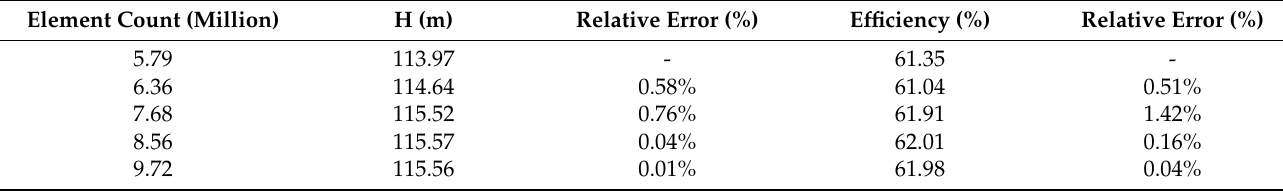
Table 2. Calculation and analysis of grid